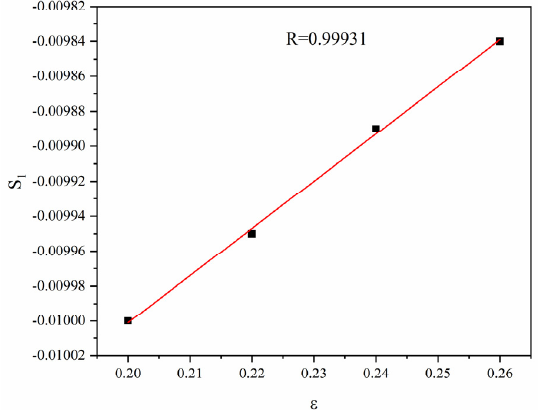
Figure 9. Linear fitting of S 1 against ε .